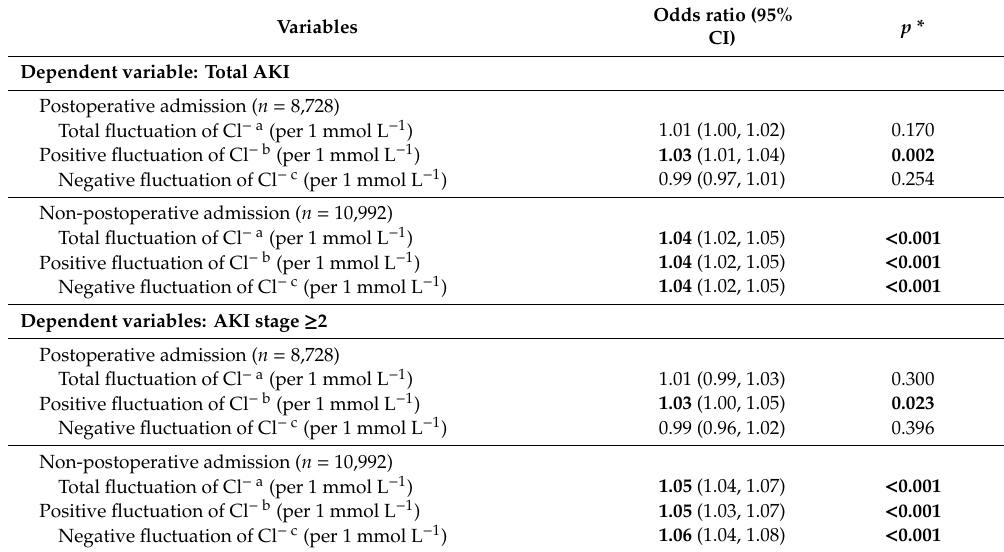
Table 4. Multivariable logistic regression analysis for total AKI and AKI (stage ≥ 2) after ICU admission according to postoperative admission.